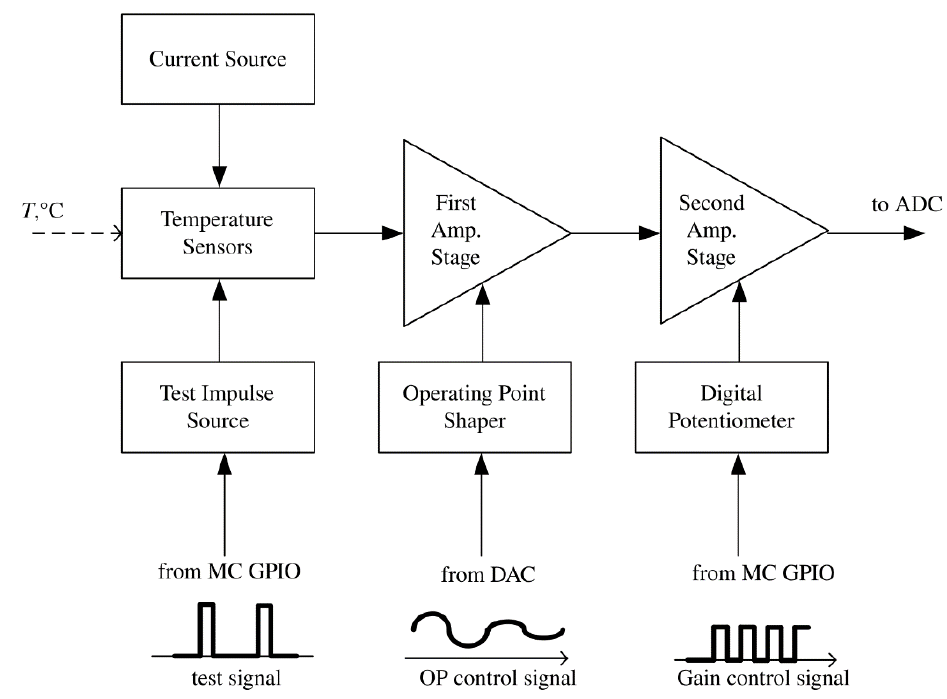
Figure 1. Structure of the temperature channel of the device. Adapted with permission from ref. [10].Copyright 2021 IEEE.